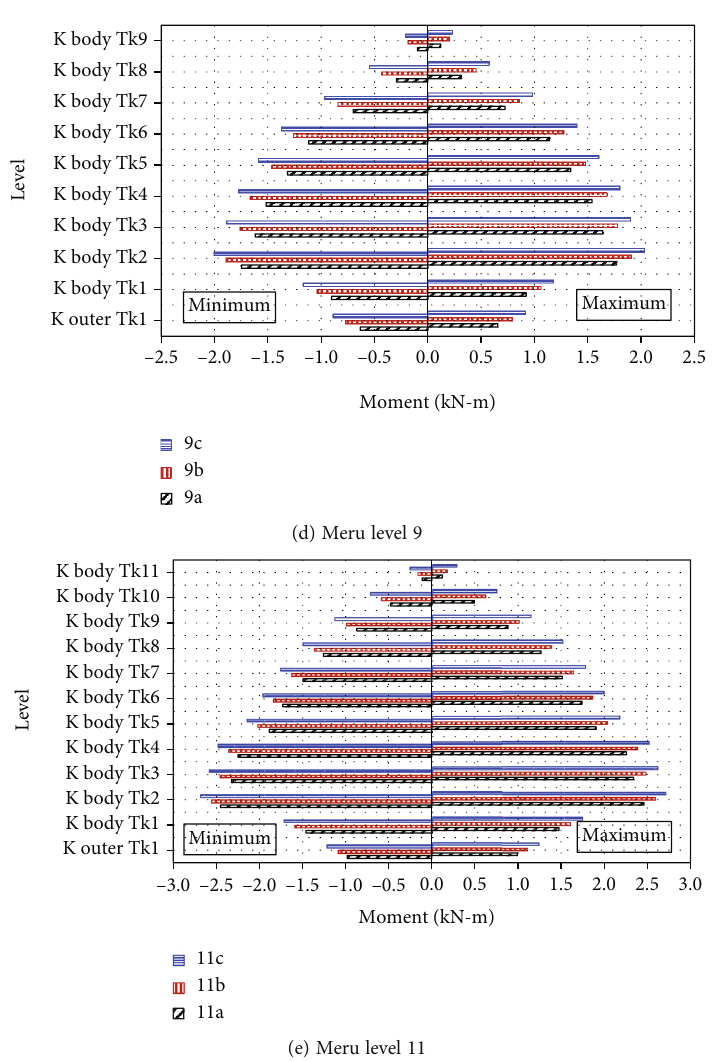
Figure 8: Column maximum moment due to earthquake load direction X for Meru levels 3, 5, 7, 9, and